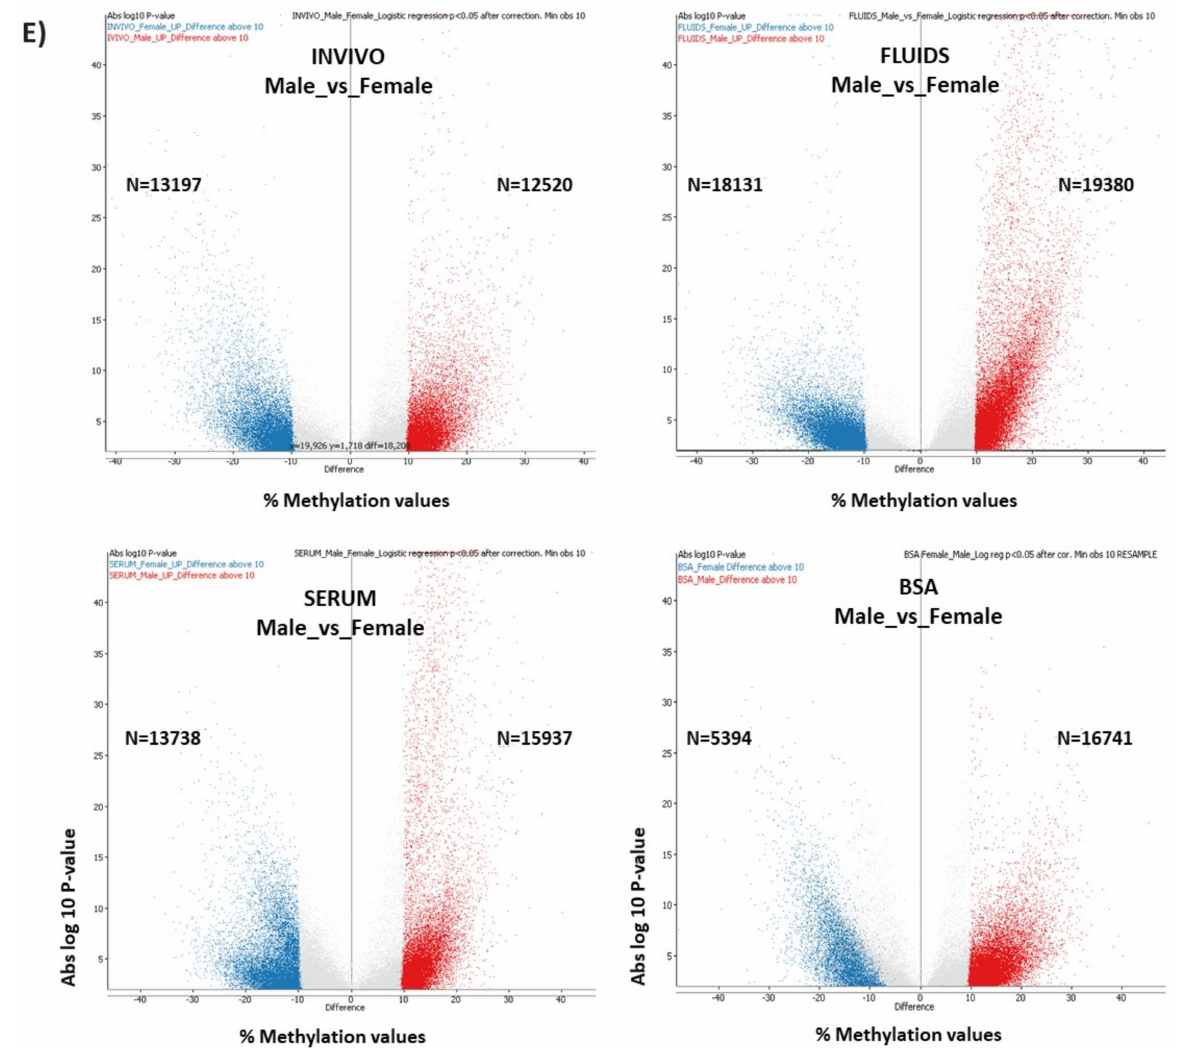
Figure 6. ( A ) Screenshot of Seqmonk genome browser at regions of Chromosome 12 and Chromosome X show examples of methylation differences between male and female blastocysts in each group and between groups. ( B ) DMTs of male and female blastocyts in each experimental group after logistic regression ( p < 0.05). Indeed, these DMTs were filtered by methylation differences over 10% of methylation. ( C ) Venn diagrams show DMTs for each pair-wise comparison. ( D ) Percentage of DMTs over total tiles per chromosome in female vs. male blastocysts for each group. ( E ) Volcano